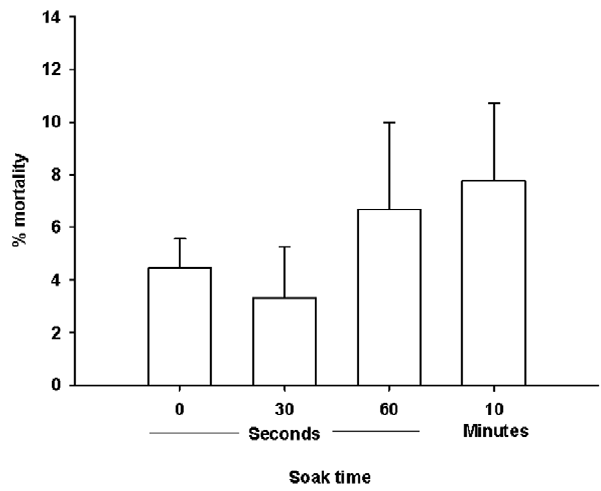
Figure 6. Effect of pre-soaking the cured eggs on the mortality of juvenile Chinook salmon. Eggs cured with cure 1 were soaked for 0 s, 30 s, 60 s, or 10 min prior to feeding. Each bar represents the % mortality in an individual tank (N=30 fish per